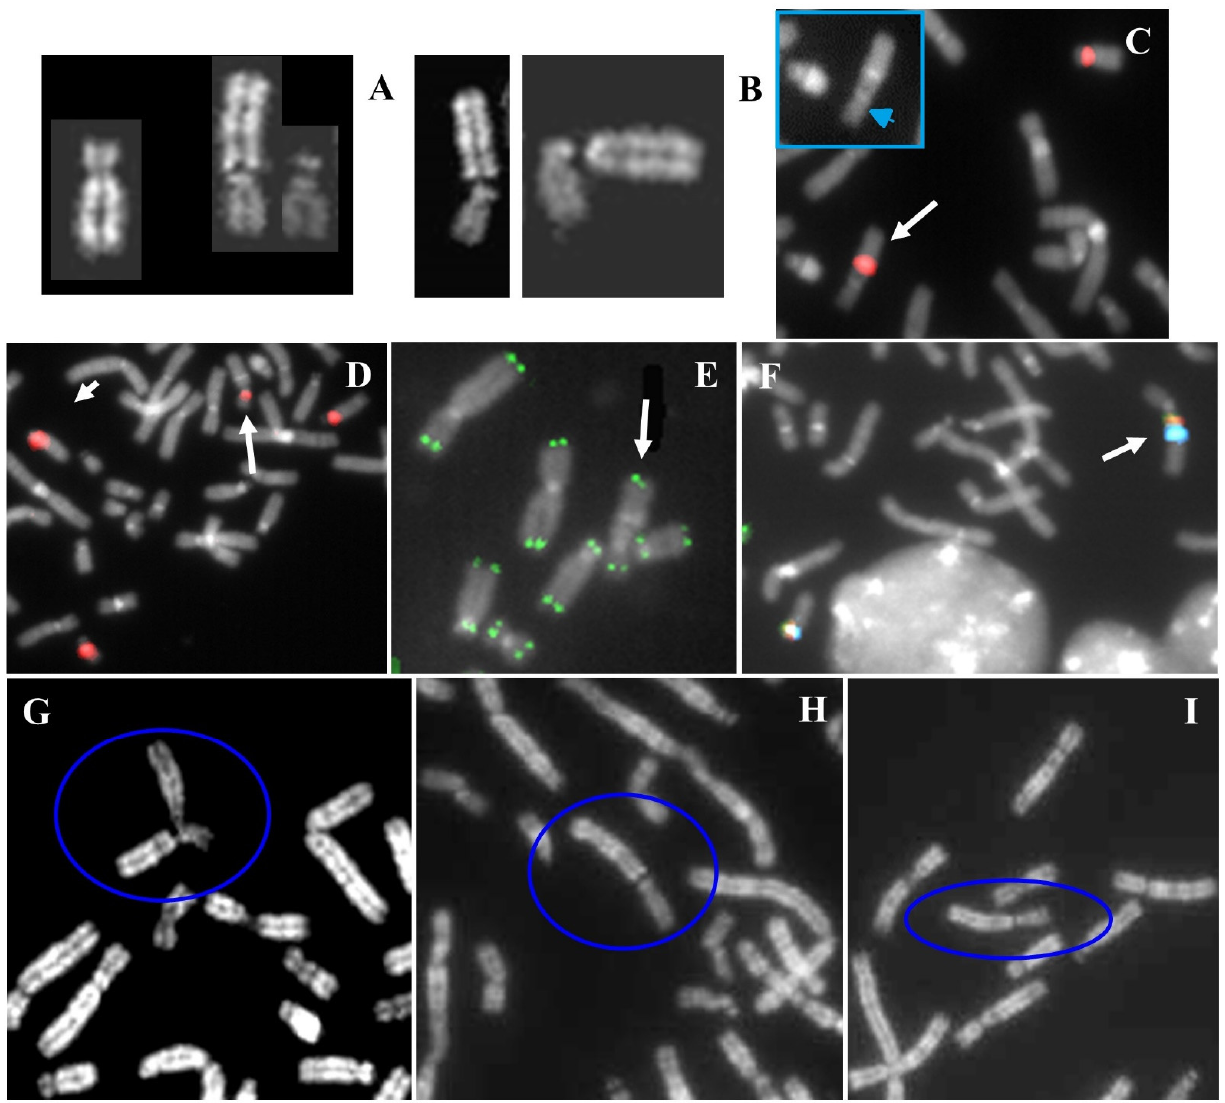
Figure 6. Telomeric case. ( A ) QFQ banded chromosomes of the proband. From left to right: normal 18, derivative t(22;18), normal 22. ( B ) Proband’s partial karyotype showing an apparent breakage of stalk 22. ( C ) FISH with D18Z1 probe: the arrow indicates the translocation. The detail shows the same image without the probe, which shows the absence of primary constriction at the inactive centromere of 18 and the presence of the unique primary constriction of chromosome 22 (arrowed head). ( D ) FISH with D14Z1/D22Z1 probe: the normal chromosomes 14 and 22 and the harrowed derivative 22;18. ( E ) FISH with common telomeric sequences shows the presence of signal at 22q and 18q and the absence of interstitial signal at reunion point 22p;18p. ( F ) FISH with D18Z1 probe (green signals) and specific 18p subtelomeric probe (red signals). The arrow indicates the translocation. ( G – I ) Partial metaphases of proband’s father, blue circles evidence the